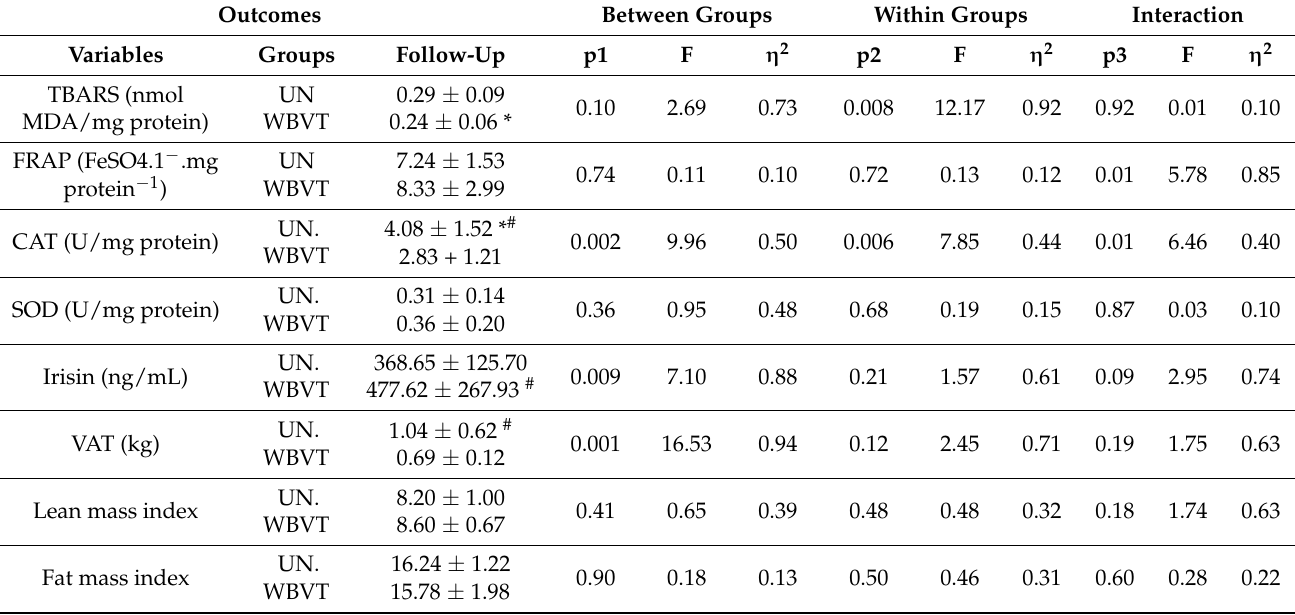
Table 3. Effects of 6 weeks of WBVT on blood oxidative stress biomarkers and irisin levels. Outcomes Between Groups Within Groups